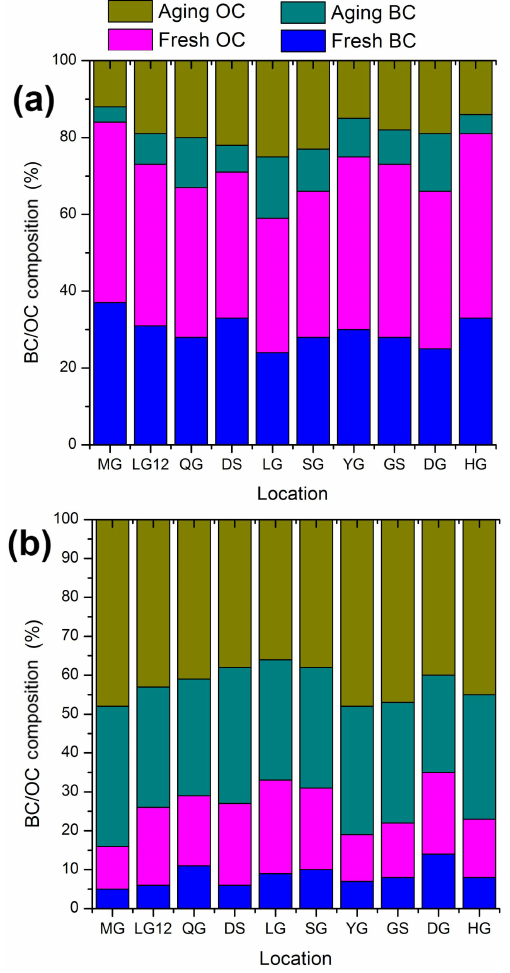
Figure 5. LAP aging of BC / OC individual impurity particles and composition ratio (%) change during the deposition process from the atmosphere to glacier–snowpack. In the figure (a) is the atmo- sphere, and (b) is the